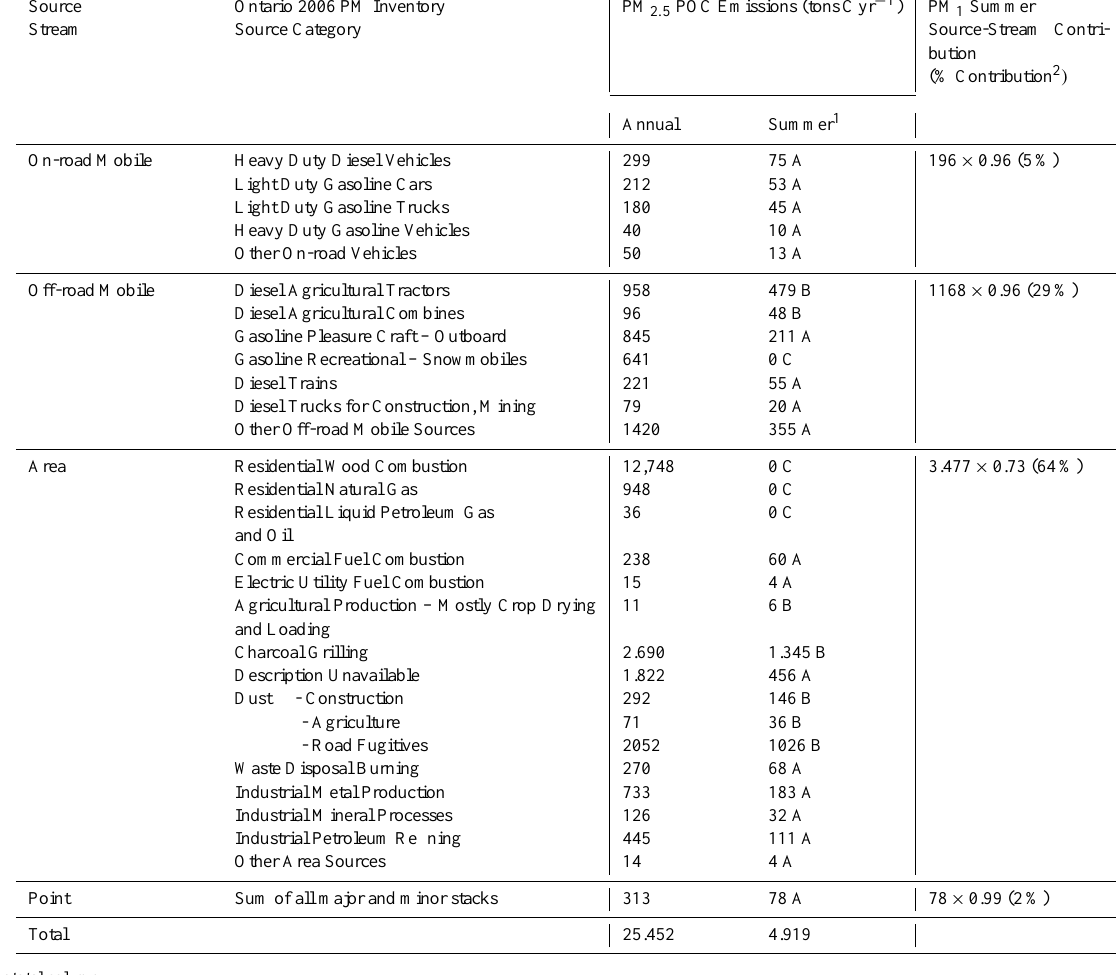
Table 1. POA emissions inventory for the province of Ontario calculated from the 2006 Canadian PM 2 . 5 NEI with the application of SCC-specific PM chemical speciation profiles and sorted by importance into four aggregate source streams (where